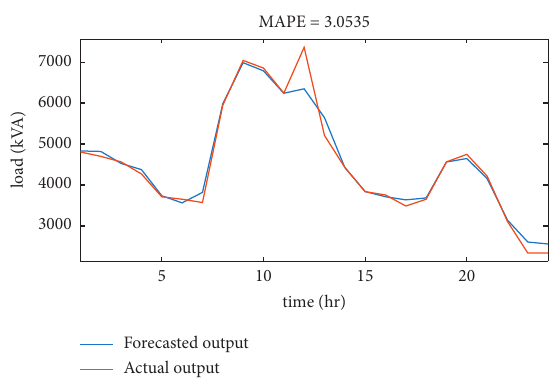
Figure 12: The Fuzzy-PSO prediction of Christmas load.